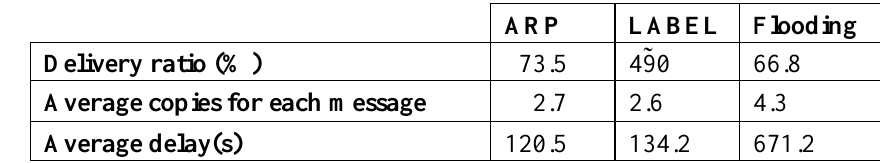
Table 4. Simulation results with default